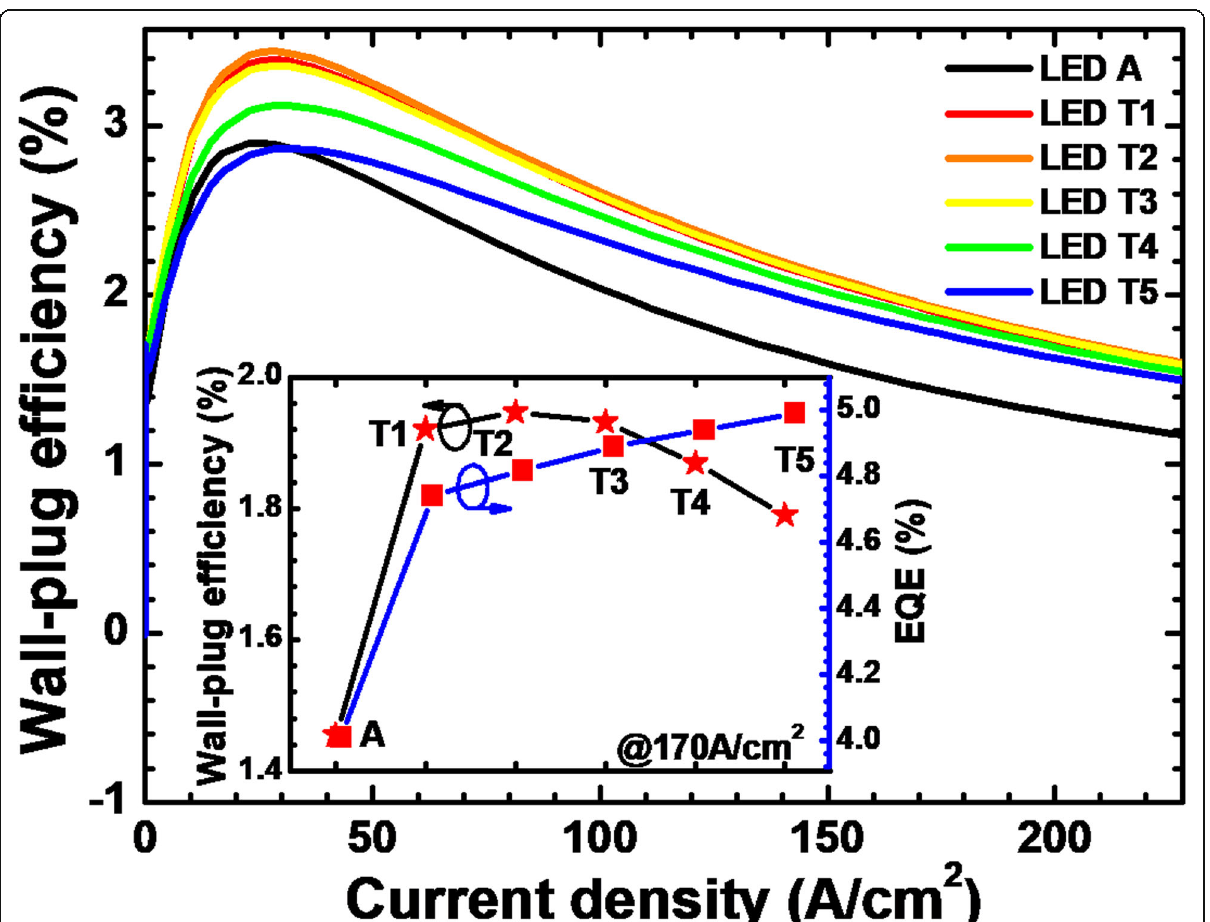
Fig. 14 Relationship between WPE and the injection current for LEDs A and T i ( i = 1, 2, 3, 4, and 5). Inset: the EQE and WPE for the investigated LEDs structured with a p-AlGaN layer with various thicknesses when the current density is 170 A/cm